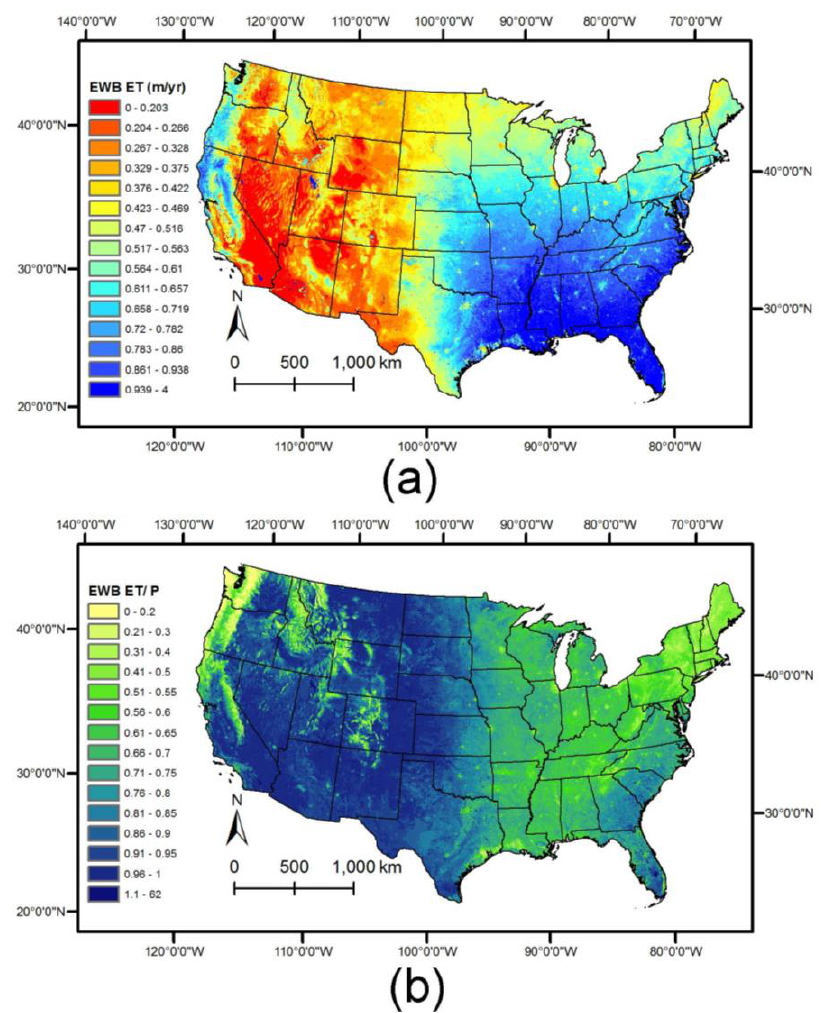
Figure 1. ( a ) Map of annual average Empirical Water Balance (EWB) ET [1] across the conterminous U.S., for the 2000–2013 time period, from [1]; ( b ) Map of annual average ratio of ET to precipitation (ET/ P ) for the 2000–2013 time period. Here precipitation ( P ) from [1] includes input from groundwater-sourced irrigation. Values exceed 1 only in locations of open water.